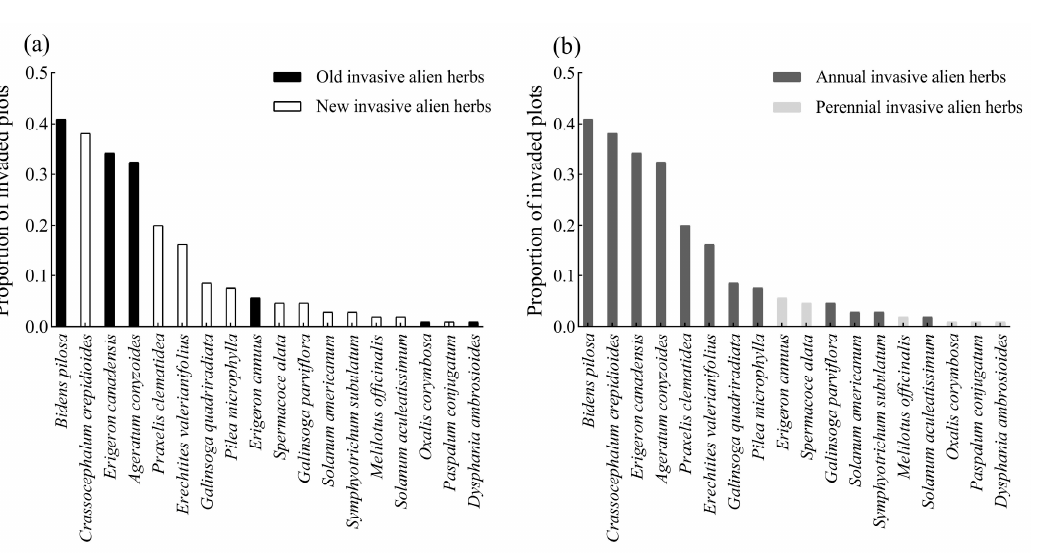
Figure 4. Altitudinal patterns of the richness of ( a ) native and all invasive alien herbs and ( b ) new and old invasive alien herbs in the Dayao Mountain Reserve. Hollow triangles and solid circles represent native herbs and all invasive alien herbs, respectively. Solid and open diamonds represent new and old invasive alien herbs, respectively. 3.3. Factors Determining the Distribution Patterns of Native and Invasive Herbs Based on the results of the linear model analysis (Table 1), the altitude pattern of native herbs was mainly explained by the temperature (Figure 5a) and could not be correlated with human disturbance (Figure 5e). The altitude patterns of all invasive alien herbs were significantly correlated with the temperature and interference intensity (Figure 5b,f). The distribution patterns of the new invasive alien herbs were mainly explained by the temperature and interference intensity